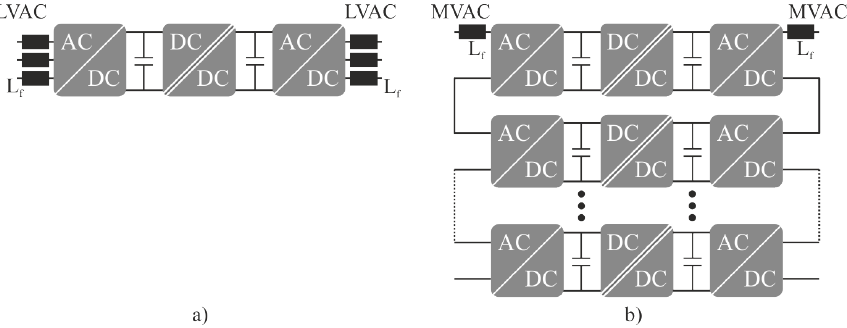
Figure 2. Selected SST Topologies: ( a ) Three-phase three-stage SST, ( b ) Cascaded H-bridge based SST (only one phase is